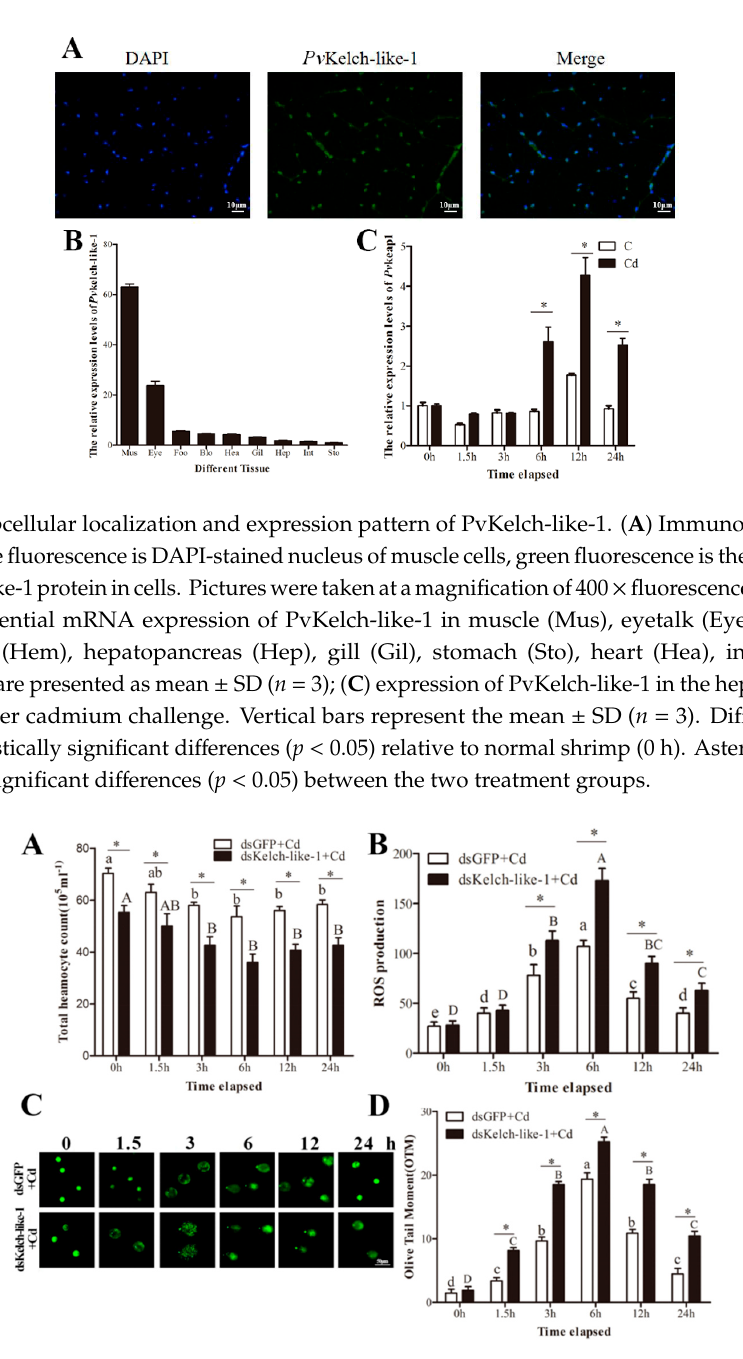
Figure 3. Effect of knockout Pv Kelch-like-1 in hemolymph. ( A ) Total hemocyte count; ( B ) endogenous reactive oxygen species (ROS) in the hemocytes; ( C ) images of DNA damage from the assayed hemocytes; ( D ) the change in DNA comet tail moment (OTM) value of hemocytes. Vertical bars represent the mean ± SD ( n = 3). Different letters indicate statistically significant differences ( p < 0.05) between Cd challenged and unchallenged shrimp (0 h). Asterisks indicate statistically significant differences ( p < 0.05) between the two treatment groups.